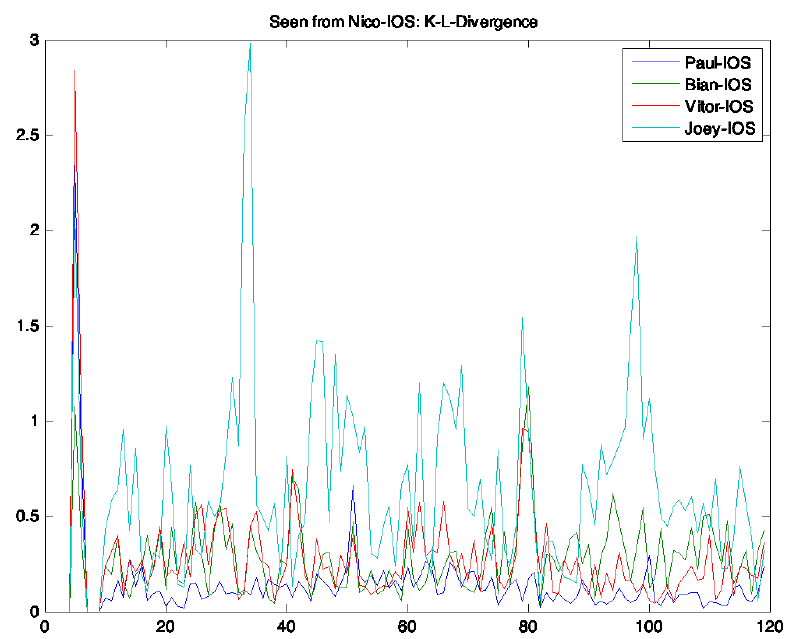
Figure 2. Example of Kullback–Leiber divergence (KLD) distance from one device to several others. The y -axis shows the calculated KLD, the x -axis time in 1 min